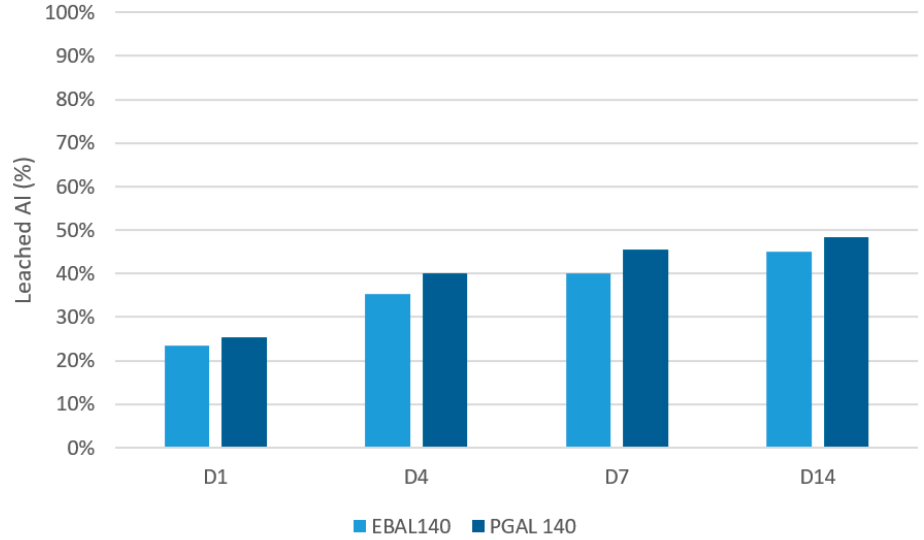
Figure 5. Cumulative leached Aluminum (%) after 1 day, 4 days, 7 days and 14 days for the different treatment.